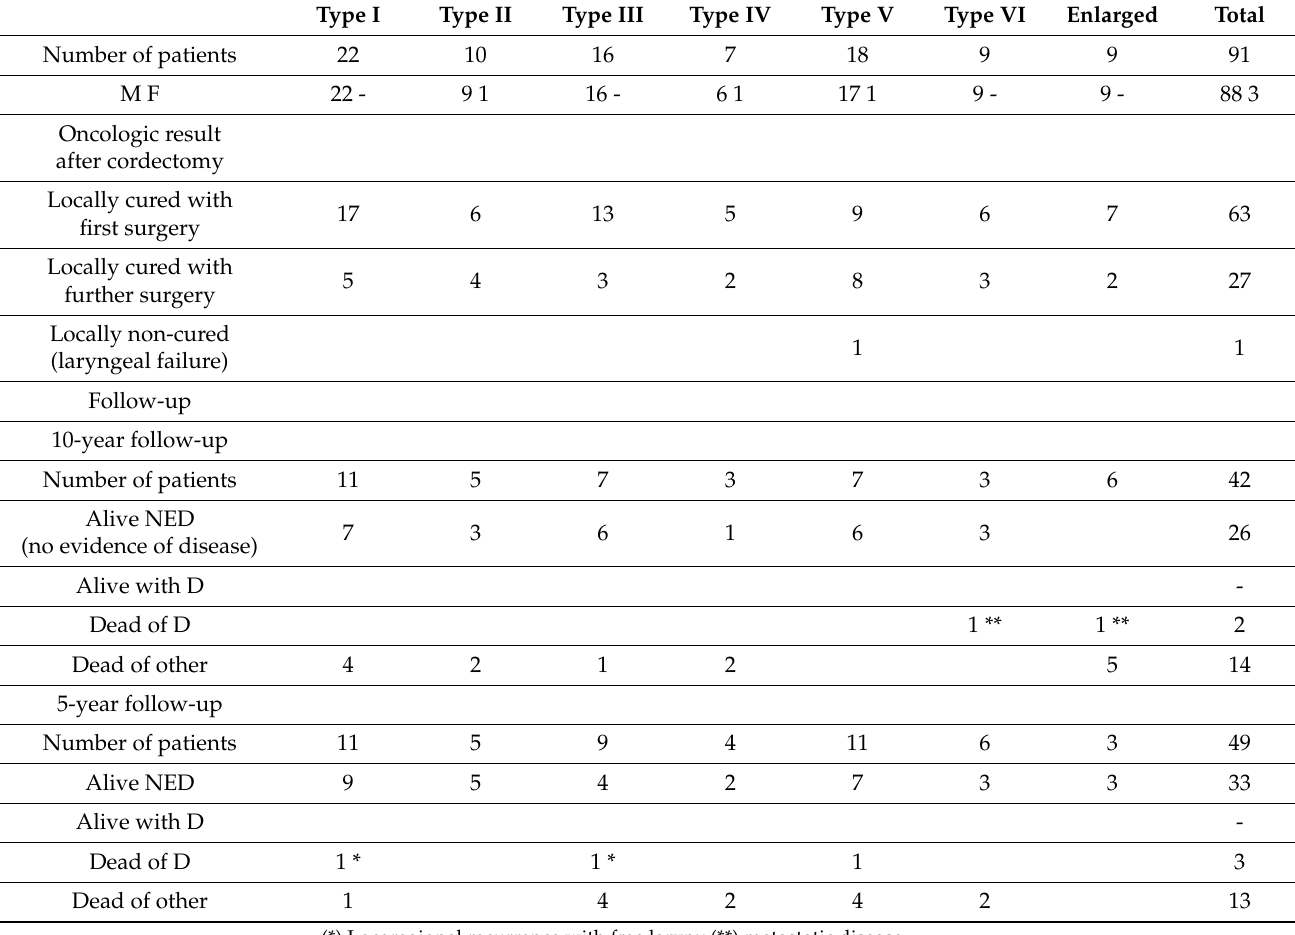
Table 4 and Figure 6 summarize the statistical analysis in terms of overall survival rate (OSR), that is the patients alive without any sign of diseases at the time of this study; Disease-specific survival (DSS), that is the whole series of patients except the ones dead with the specific disease; and disease-free survival (DFS), that accounts for the patients alive after the first